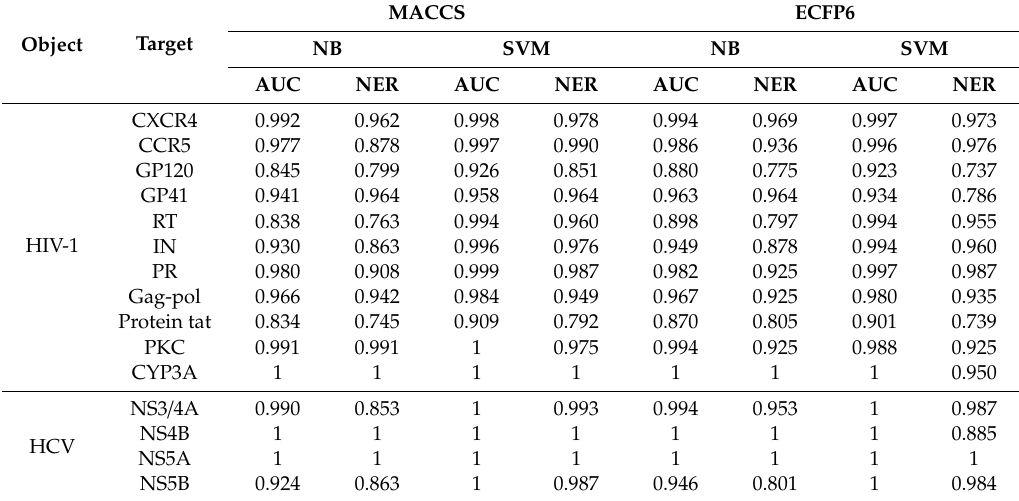
Table 2. Performance results for the 60 multiple QSAR models determined by five-fold